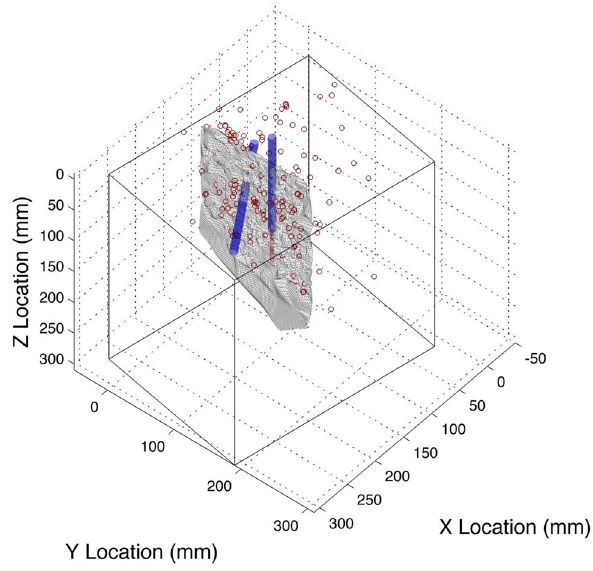
Fig. 9 Predicted hydraulic fracture from AE